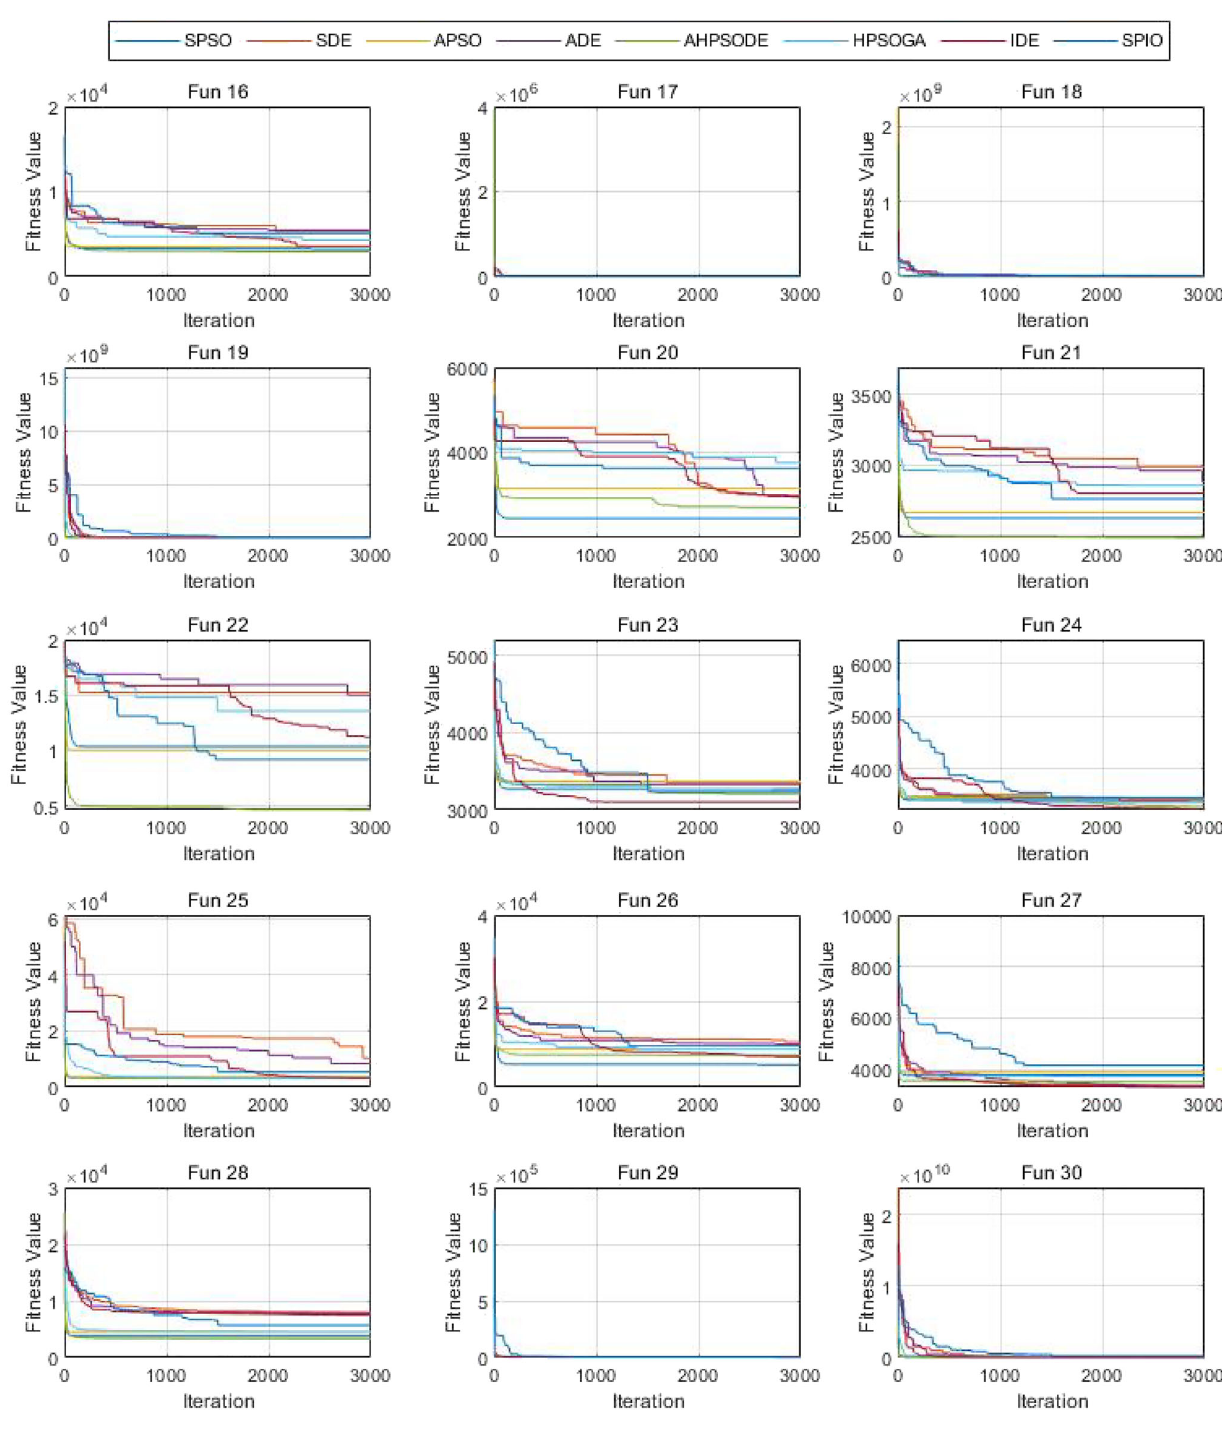
Fig. 26 Convergence curve of different algorithms on CEC 2017 at 50-D (Fun